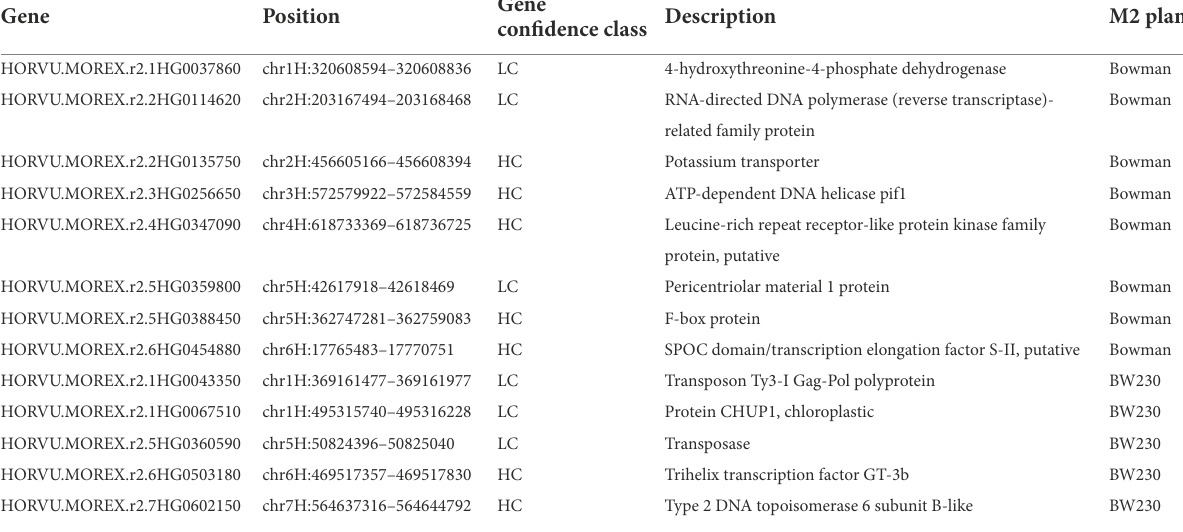
TABLE 1 Nonsense gene mutations in the M2 plants.